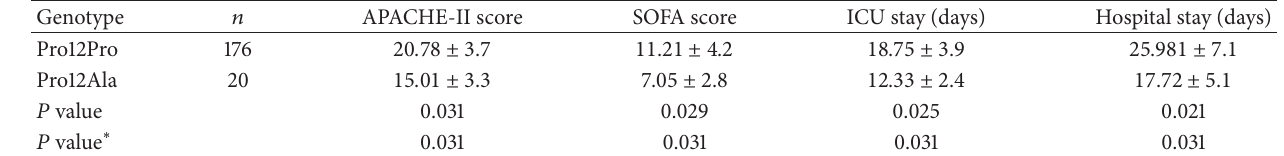
Table 5: Association between genotype and sepsis outcome in the survivor group.